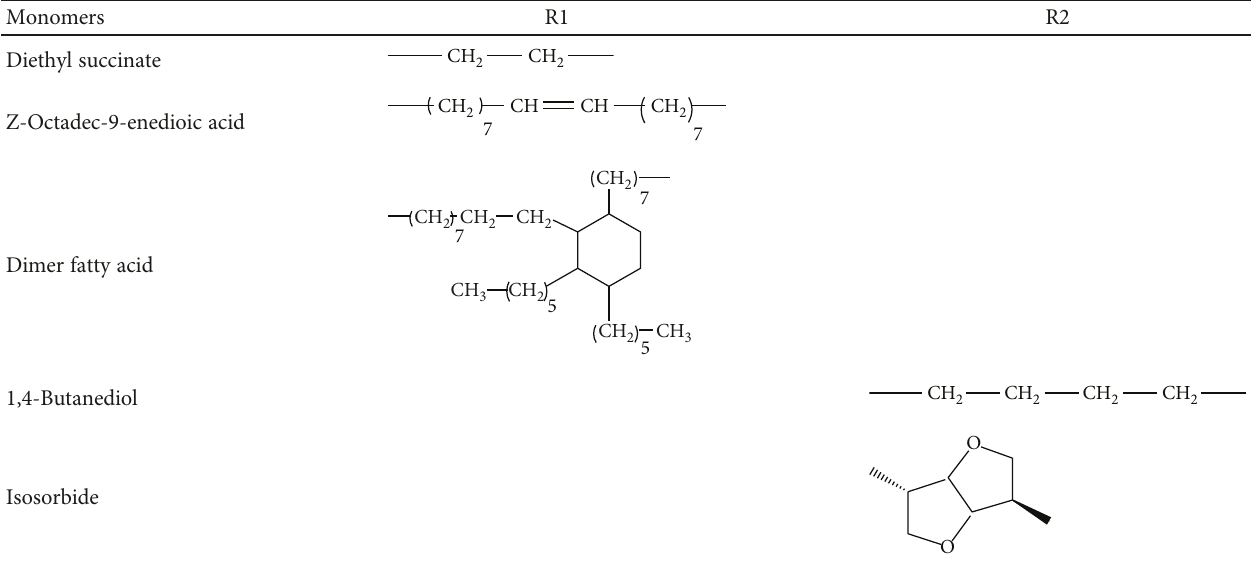
Table 1: Biobased monomer